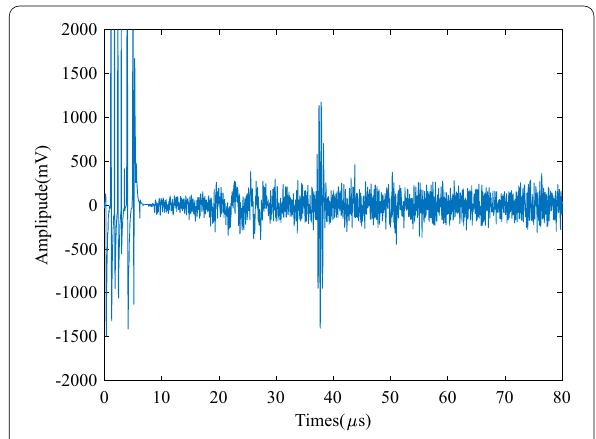
Figure 13 Detection of electromagnetic ultrasonic signals in Cr25Mo3Ti at 25 ℃ and 250